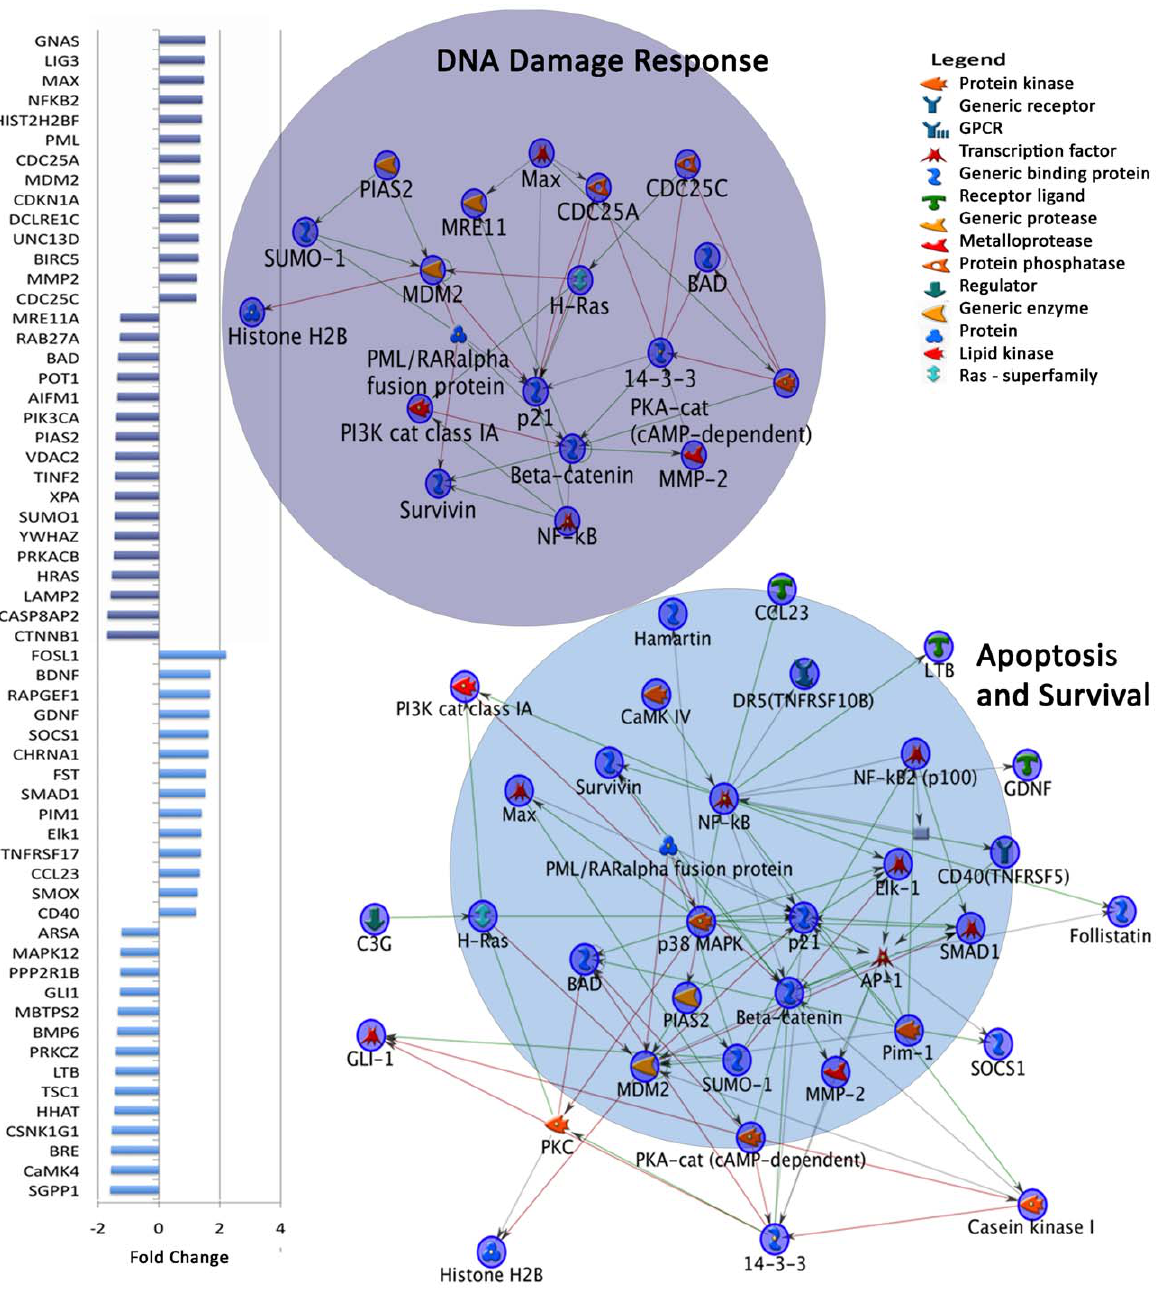
Figure 3. Dysregulated gene expression in top two MetaCore Map Folders in autism independent of age. Graph on left shows fold change of genes in DNA damage response and apoptosis and survival Map Folders. The third most significant map folder is depicted in Figure S3. Colors on fold change graph correspond to circles on the left depicting network maps in each category. From each category of differentially expressed genes in the all autistic vs. all control comparison (Table S5), networks were created using MetaCore Network Analysis.